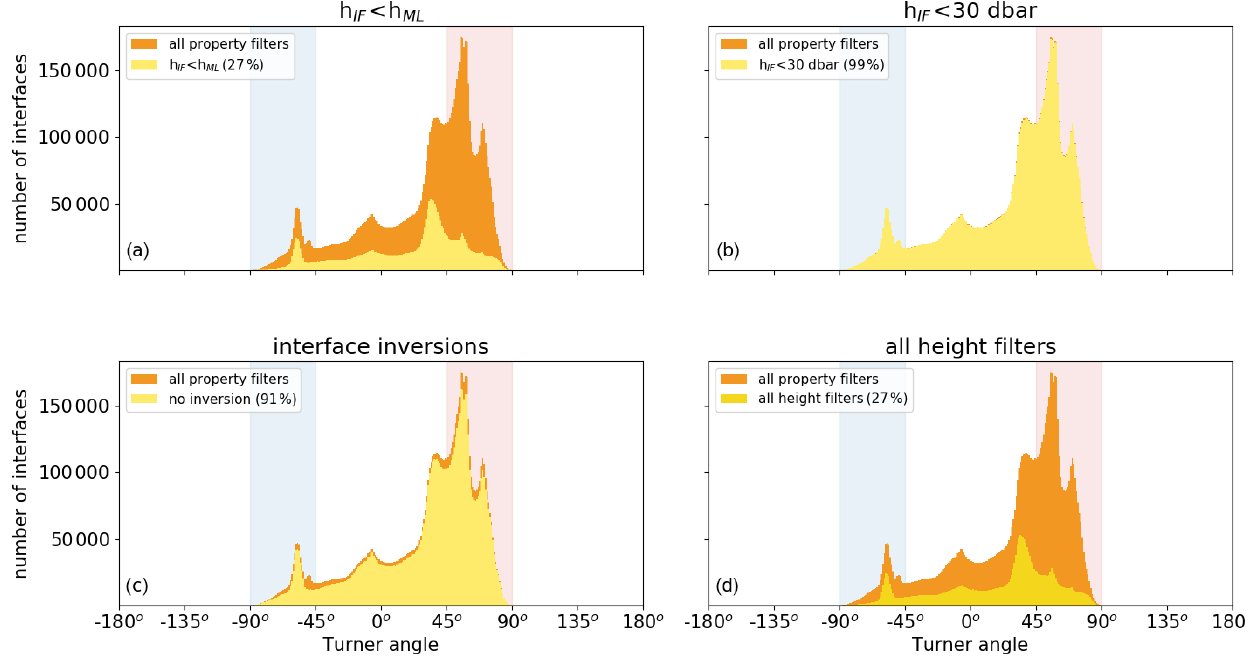
Figure 5. Histogram of the number of detected interfaces as a function of the Turner angle (Tu) by applying a criteria for (a) height, (b) maximum height, (c) inversions, and (d) all three height limitations (yellow shading). Each panel shows the data remaining compared to the interfaces detected based on the conservative temperature and absolute salinity requirements shown in Fig. 4d (orange shading). Vertical shaded bands correspond to Turner angles in the diffusive-convective (blue) and salt-finger (red) regimes.